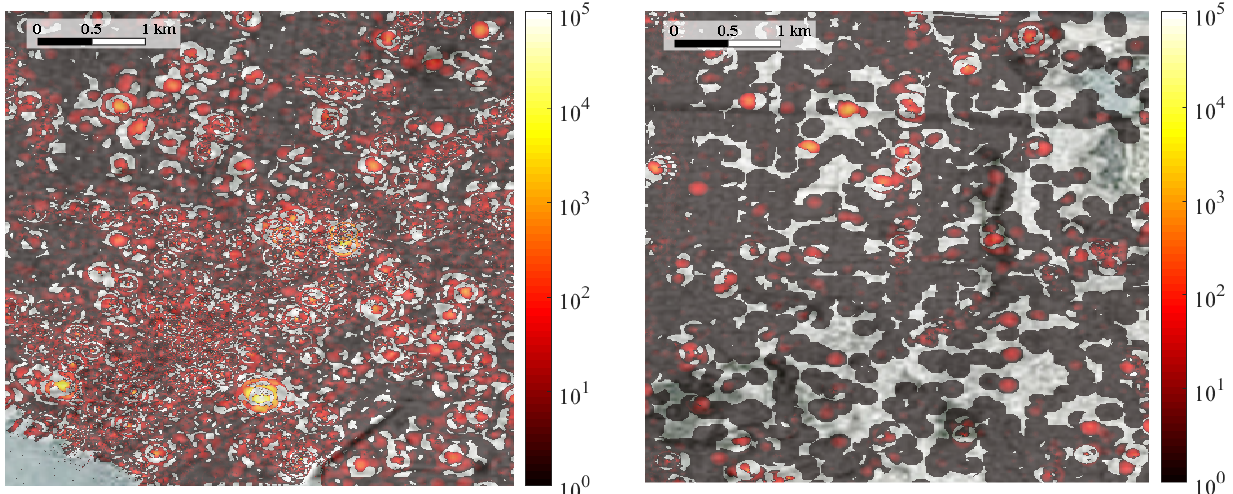
Figure 4. Sections of M (cid:48) p ( x , y ) in the